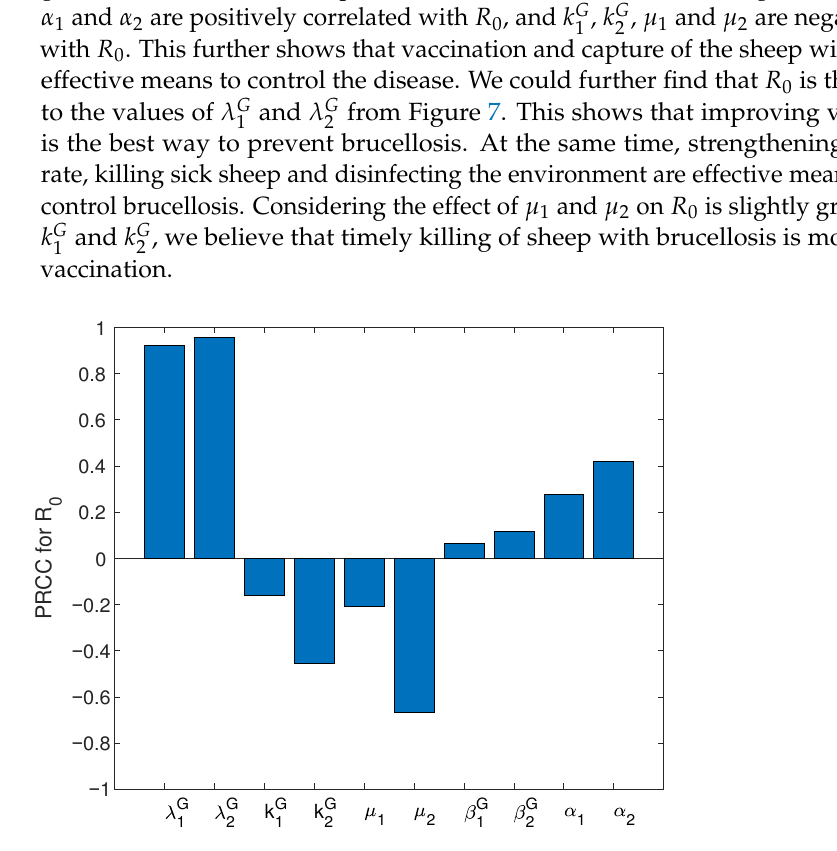
, λ G , k G , k G , µ 1 , µ 2 , β G 2 2 1 1